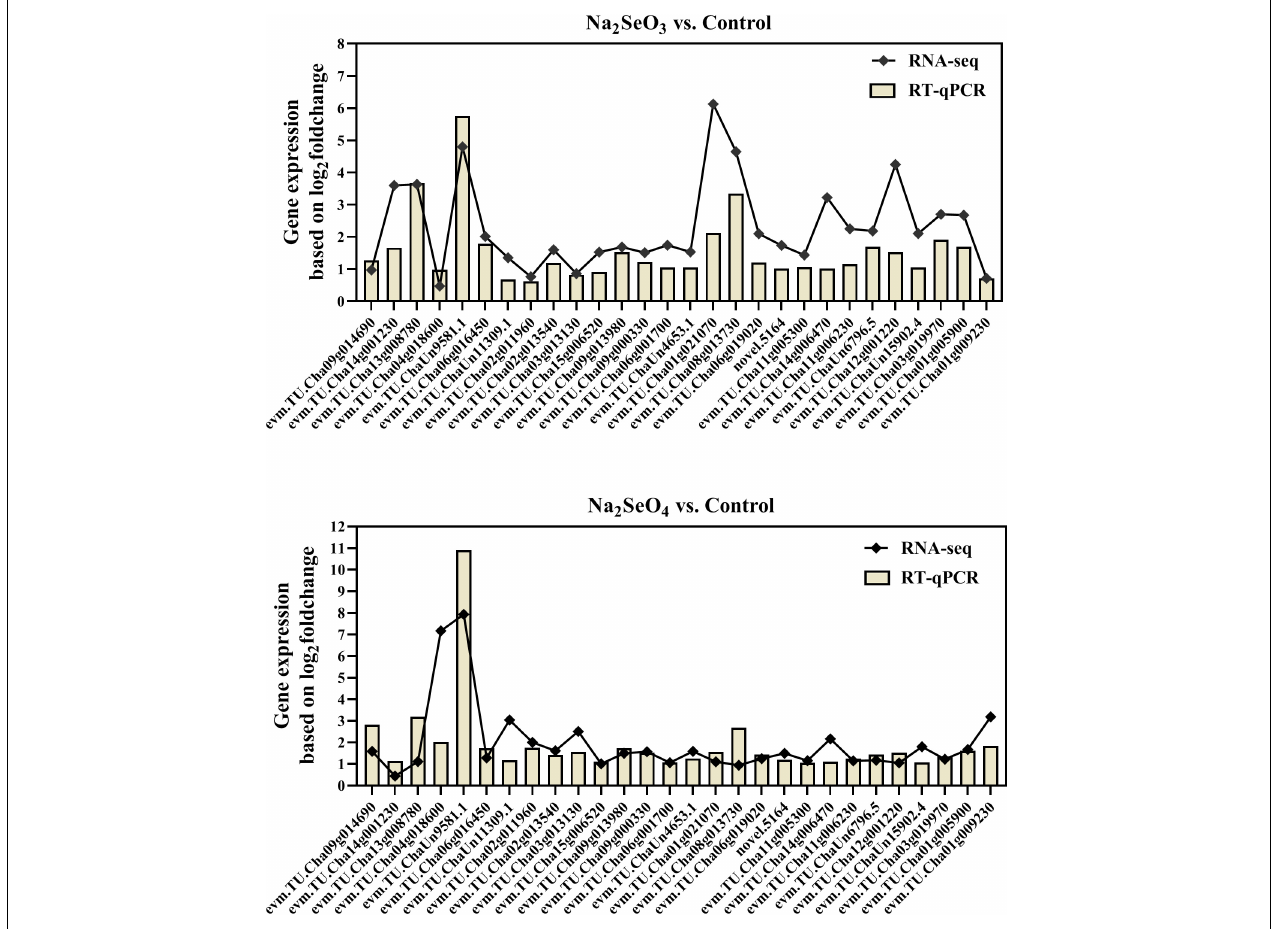
FIGURE 8 | Validation of gene expression by